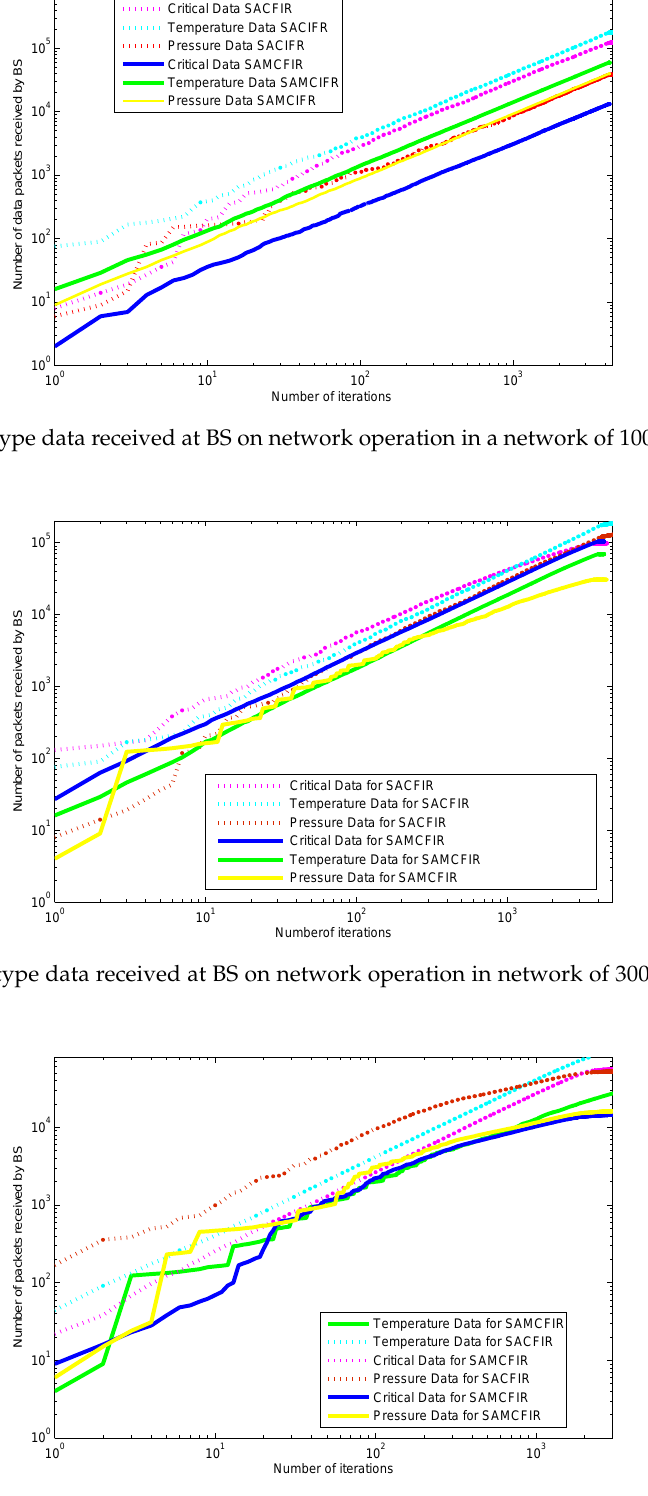
Figure 16. Multi-type data received at BS on network operation in network of 450 m × 450 m with 300